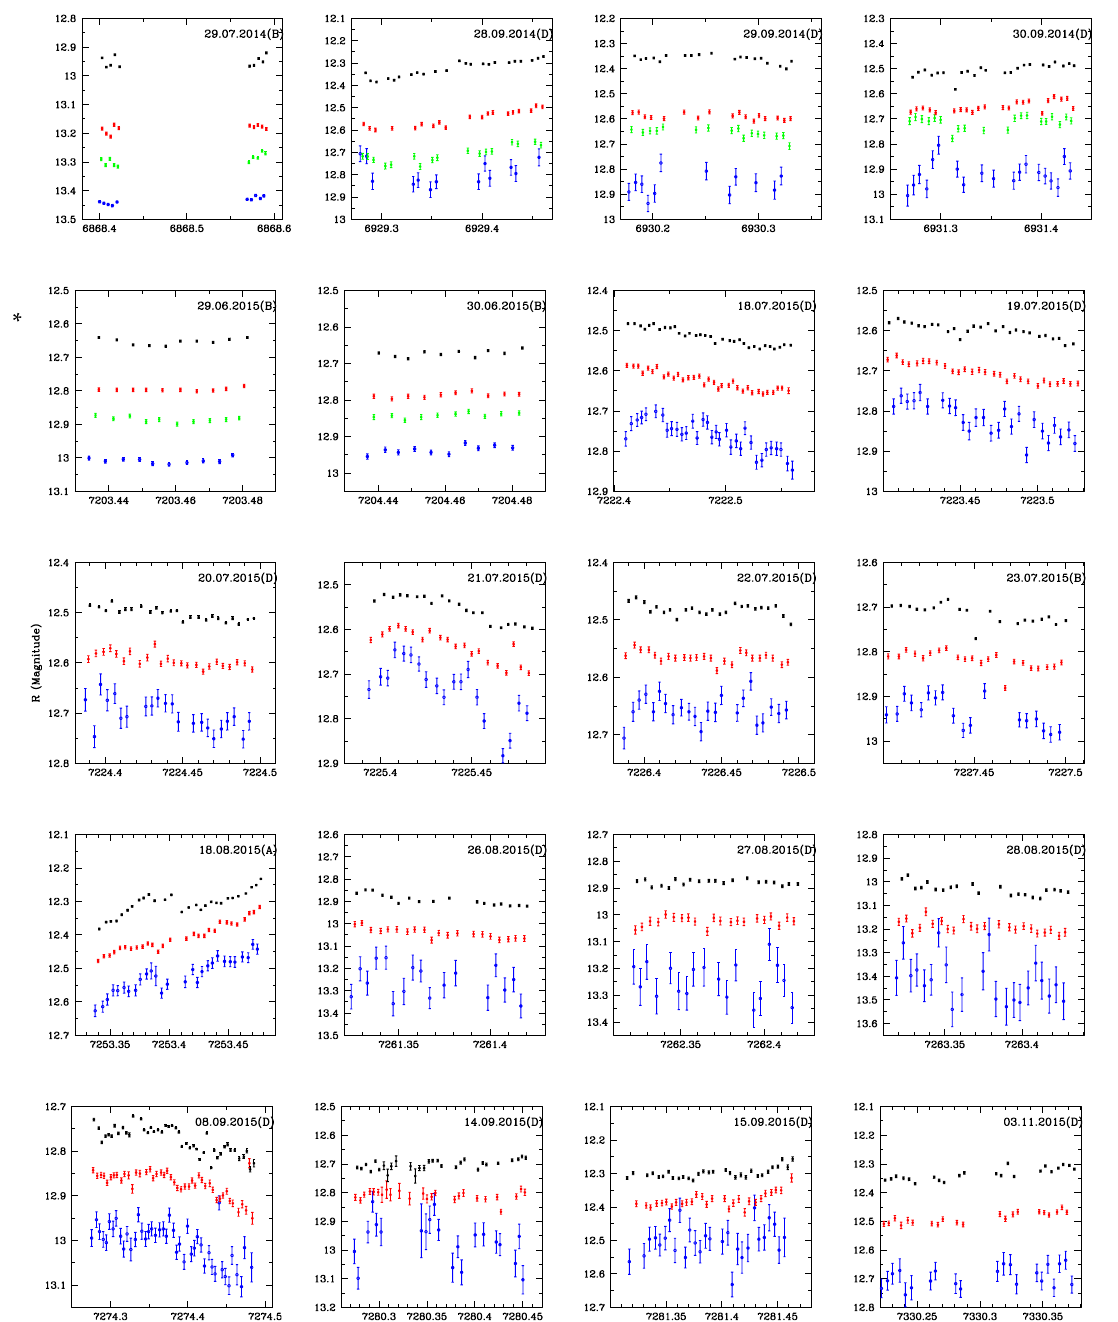
Figure 1. IDV LCs for BL Lacertae from July 2014 through November 2015 in the B (blue), V (green), R (red) and I (black) bands. The x -axis is JD (2455000+), and the y -axis is the calibrated R band magnitudes in each of the panels. For clarity, the B, V and I LCs are shifted by arbitrary offsets with respect to the R-band